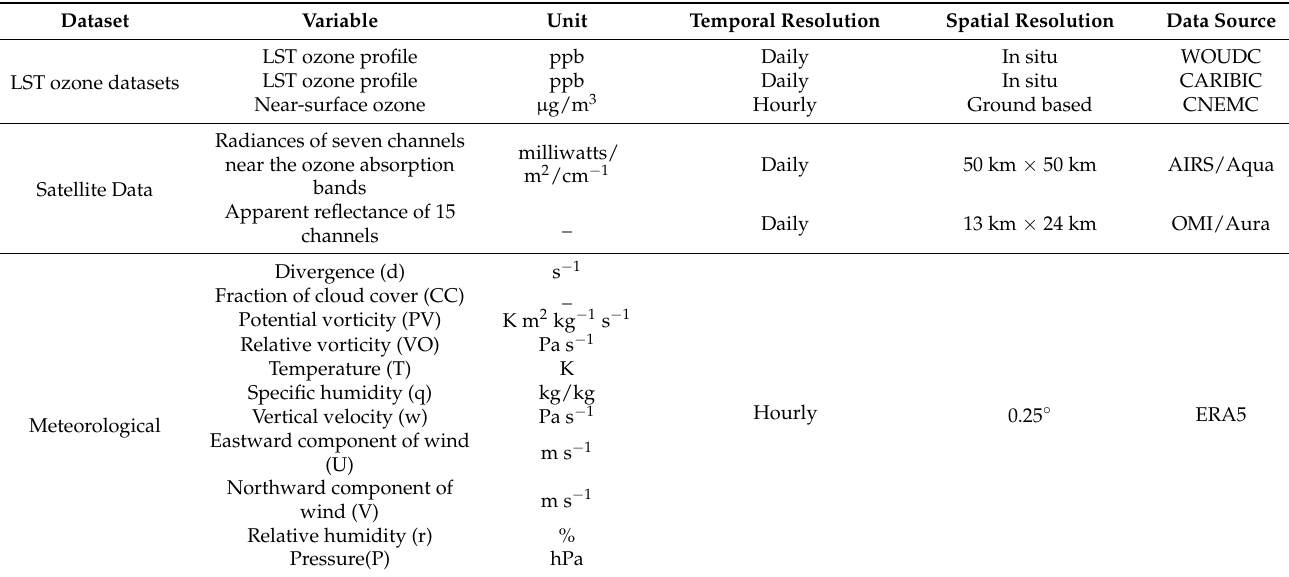
Table 1. Datasets selected for the study. LST: Lower-Stratosphere-to-Troposphere; CNEMC: China National Environmental Monitoring